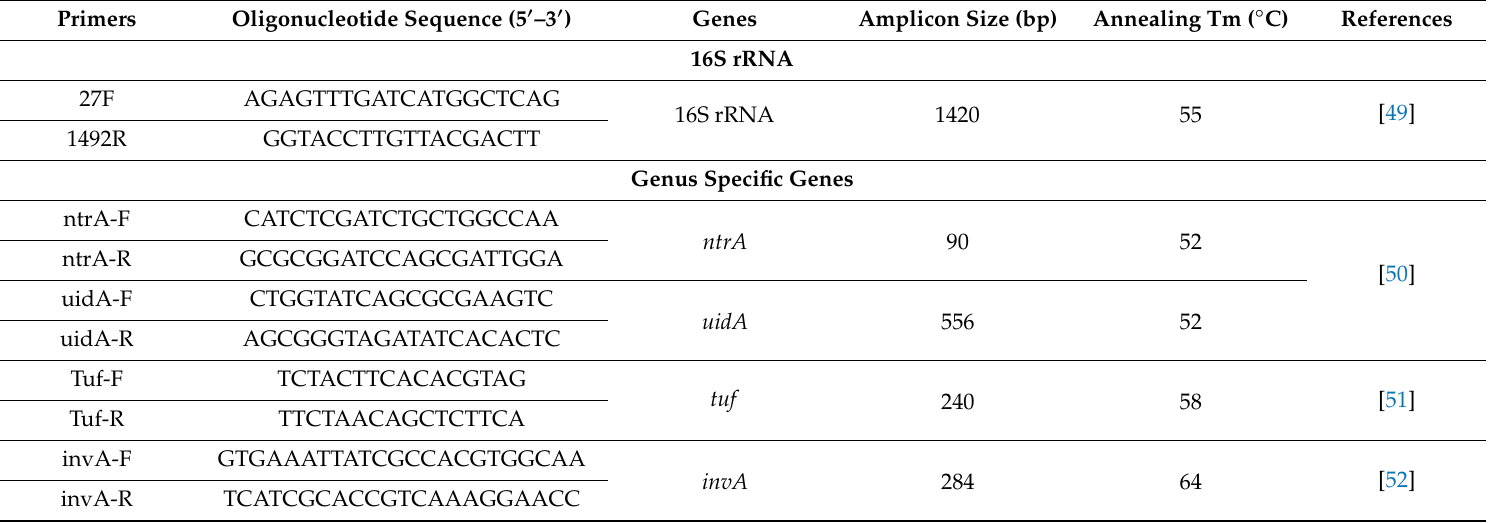
Table 3. List of oligonucleotide primer sequences and PCR conditions used in this